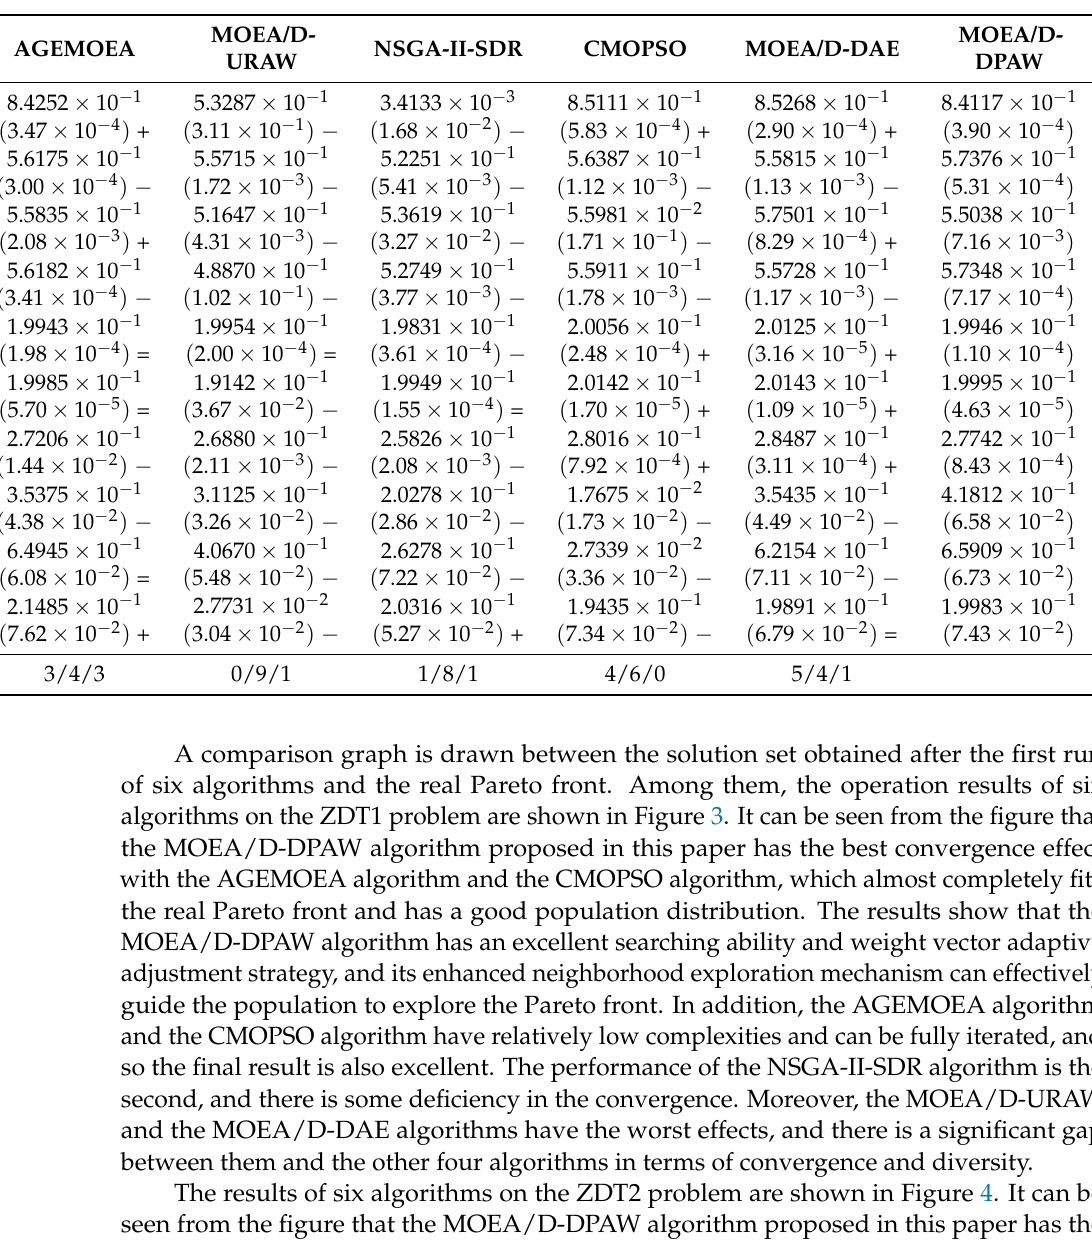
Table 4. HV values obtained by six algorithms about three-objective optimization problems on DTLZ and